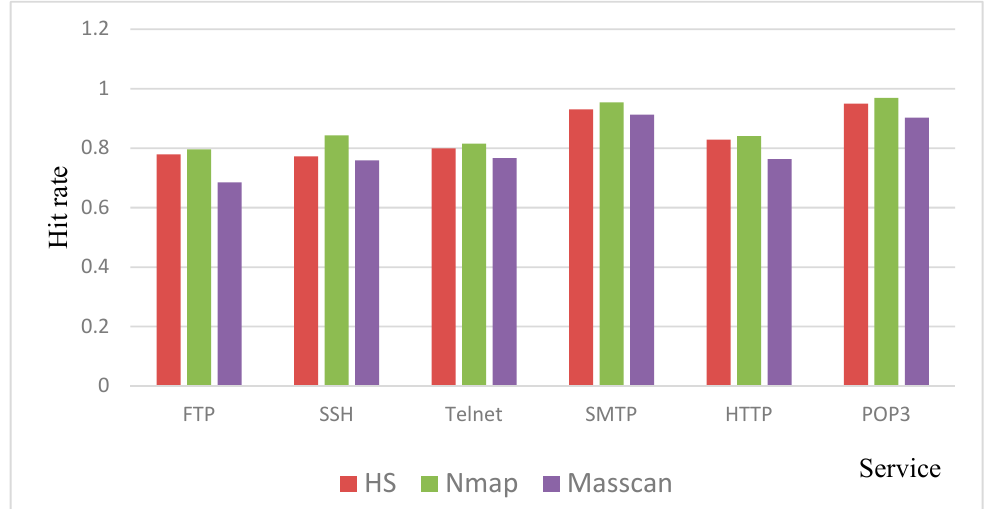
Figure 8. The comparison of hit rate.